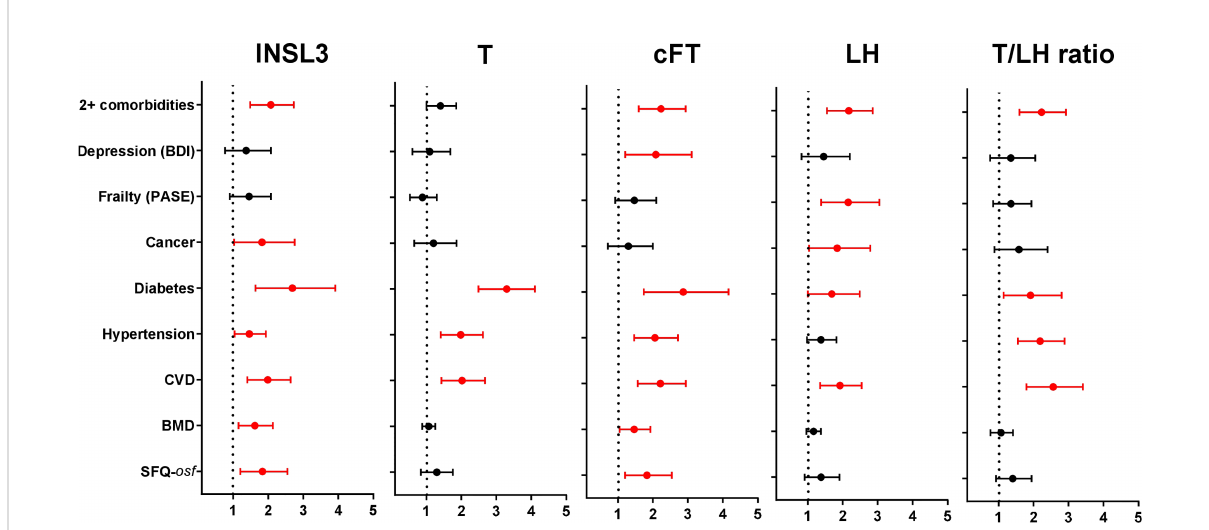
FIGURE 4 Odds Ratios (OR; mean and 95% con fi dence intervals) calculated from multivariate binomial logistic regressions of the indicated binomial categorical variables representing different morbidities from phase 2, as indicated on the Y axis, against various hormonal parameters from phase 1 as independent predictors, here represented as binomial categorical variables. INSL3, T, cFT, and T/LH ratio: lowest quartiles vs remainder; LH: highest quartile vs remainder. Signi fi cant OR are indicated in red; non-signi fi cant relationships are excluded (not shown). BMD and SFQ- osf are expressed as binomial categorical variables, as in the legend to Figure